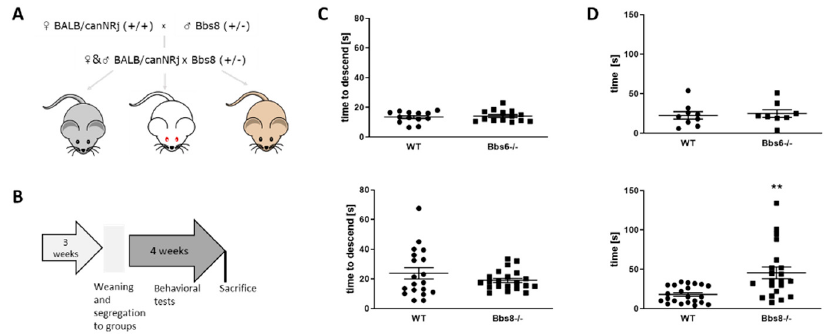
Figure 2. Behavioral testing scheme and test-prerequisites. ( A ) Breeding scheme of Bbs8 knockout mice. Male Bbs8 − /+ mice were crossed to BALB/canNRj female mice and the derived F1 offspring were mated to obtain F2 (Bbs8 − / − or Bbs8+/+). Only F2 animals were used for the investigations. ( B ) Timeline of behavioral testing. Sacrifice was conducted at the age of 8 weeks. ( C )